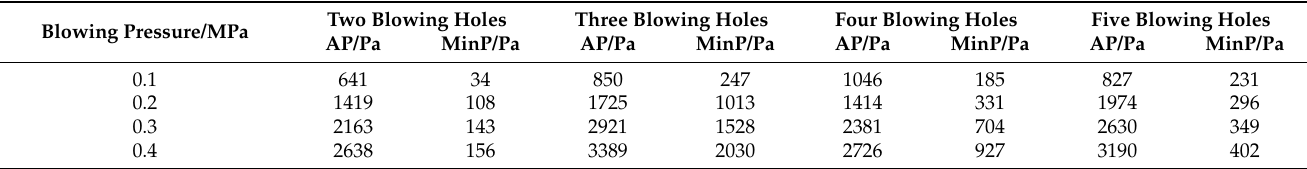
Table 5. Average surface side wall peak pressure (AP) and minimum surface side wall peak pressure (MinP) under different types of blowing holes with different blowing pressures (blowing distance of 20 mm).